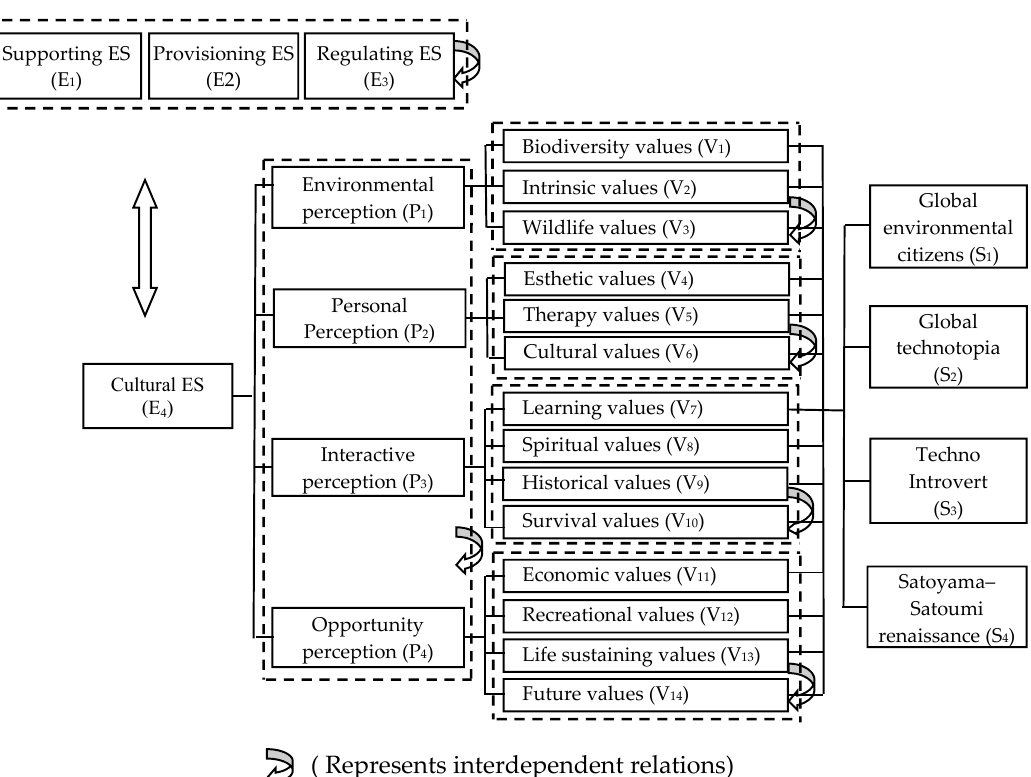
Figure 2. CES evaluation models of rural landscapes in Taiwan.